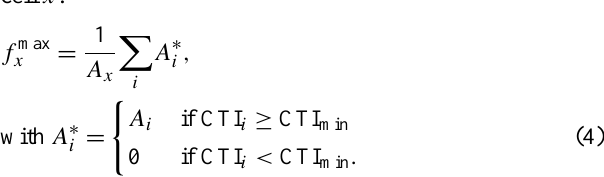
tion ˆ f x of this grid cell for each (cid:48) x (see Eq. 2). This relation- ship is distinct for each grid cell and is illustrated in Fig. 2 for two example grid cells. Having to rely on the full information CTI i is computationally costly due to the (necessarily) high spatial resolution of CTI i